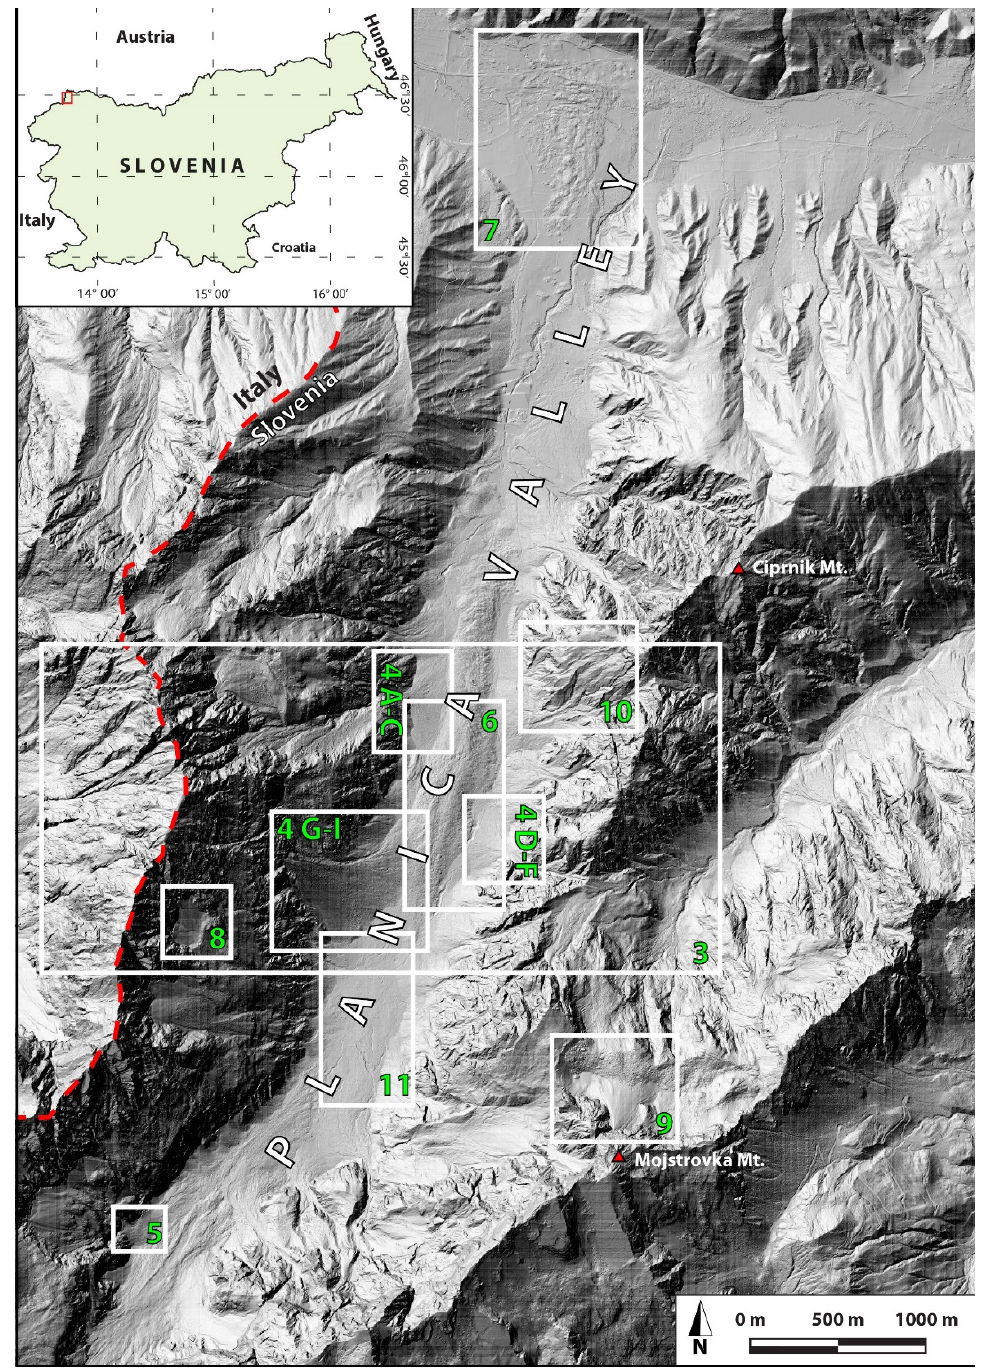
Figure 1. Study site of the Planica valley in NW Slovenia. White rectangles and corresponding numbers refer to locations and Figures of Quaternary sedimentary bodies studied in detail in the produced visualisations. DEM is produced from freely available ALS data source [53].